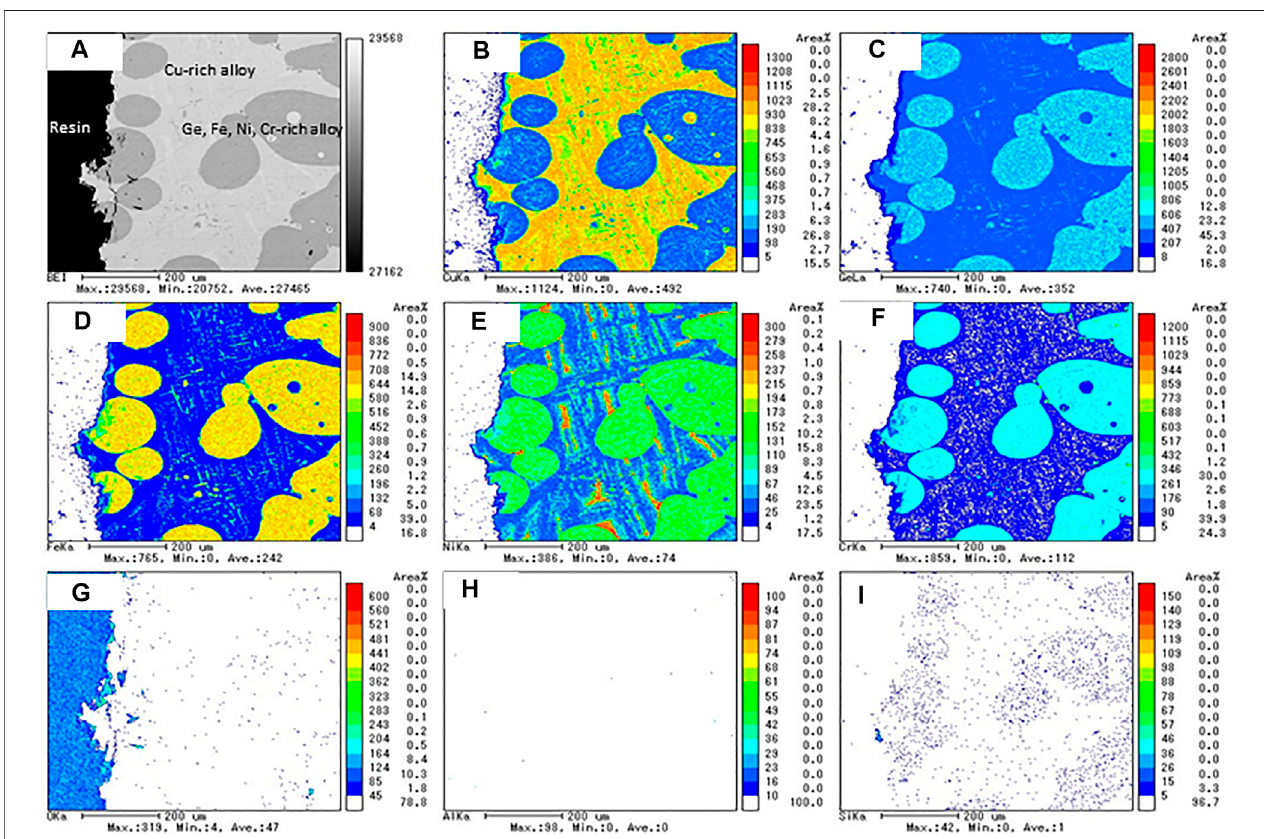
FIGURE 9 | The results of the EPMA analysis for the chemical compatibility test of SUS 310S/CuGe50. (A) BEI image, (B) Cu, (C) Ge, (D) Fe, (E) Ni, (F) Cr, (G) O, (H) Al, and (I) Si mapping images.